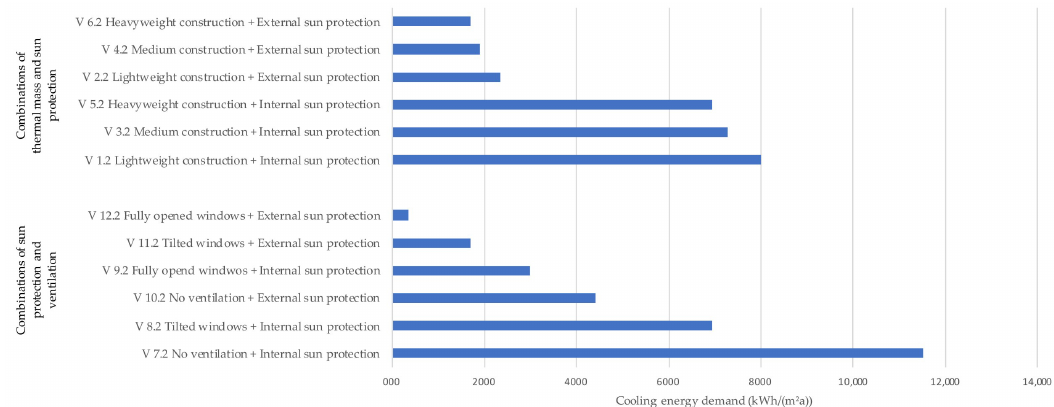
Figure 9. Future climate scenario—Cooling energy demand, based on